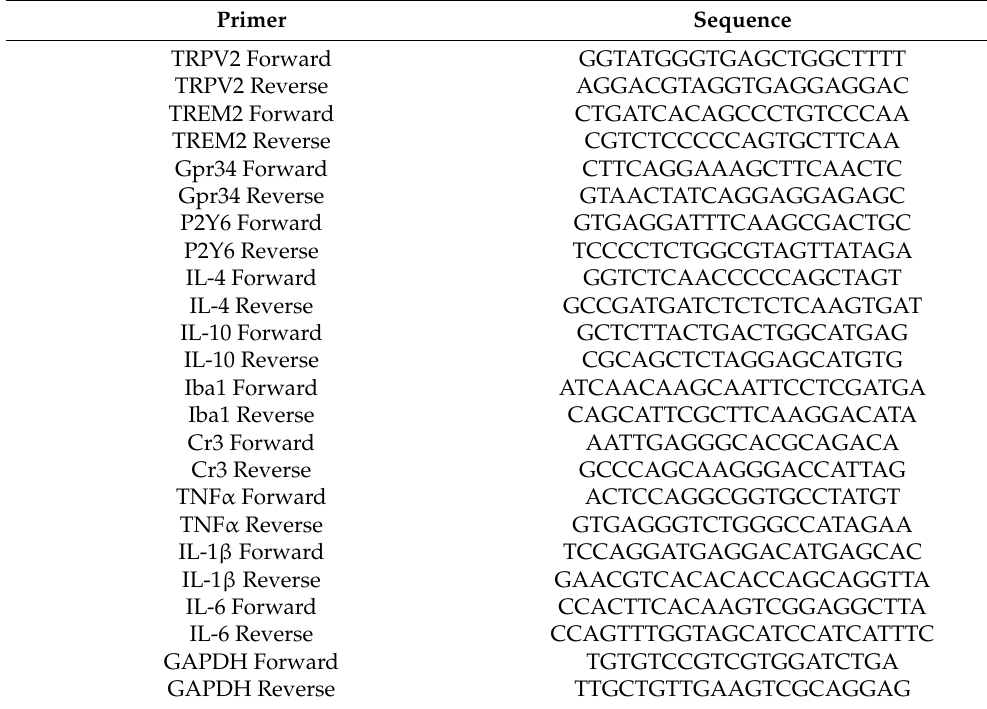
Table 1. Primers and their sequences for fluorescence quantitative